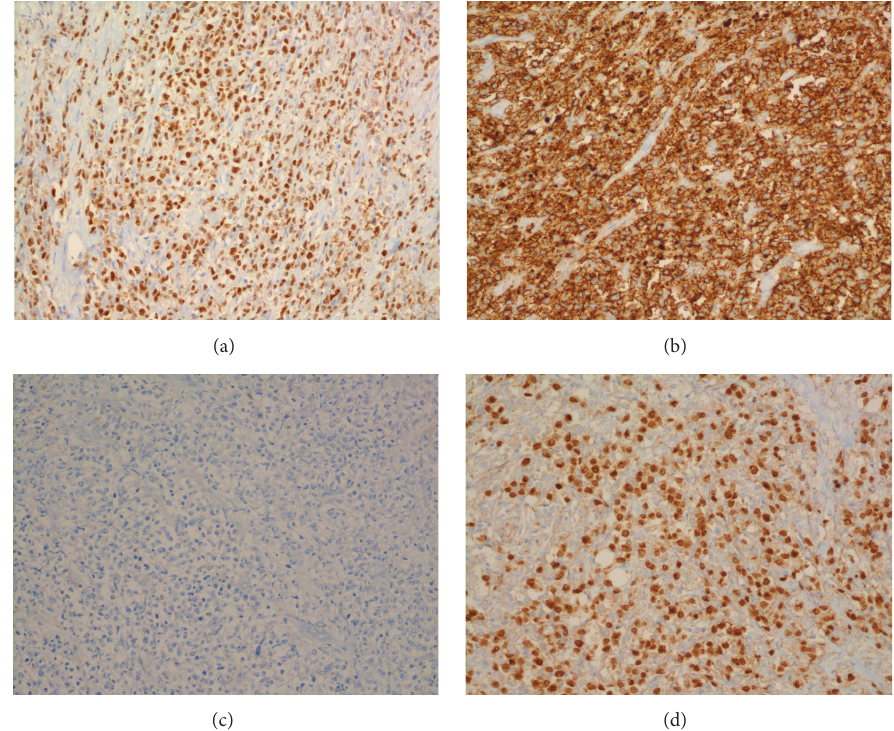
Figure 2: Immunohistochemical staining pattern and diffuse large B cell lymphoma of the bladder. (a) p63 positive, (b) CD20 diffusely positive, (c) pancytokeratin negative, and (d) PAX-5